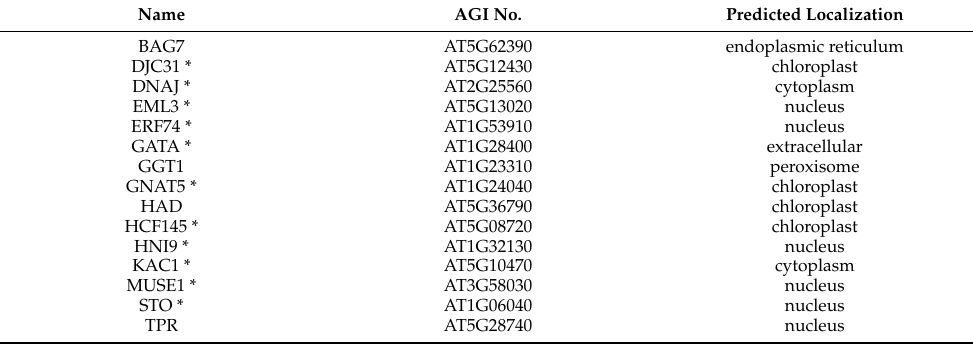
Table 1. GUN1-interacting proteins identified by yeast two-hybrid